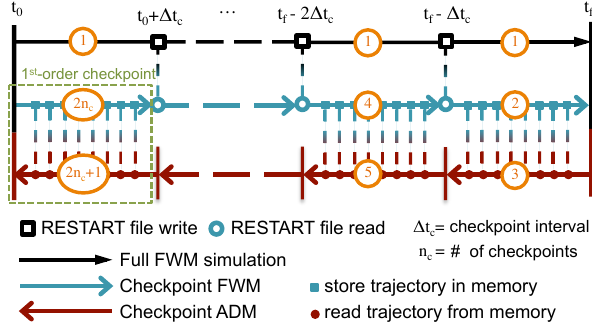
Figure 3. Second-order checkpointing scheme implemented in